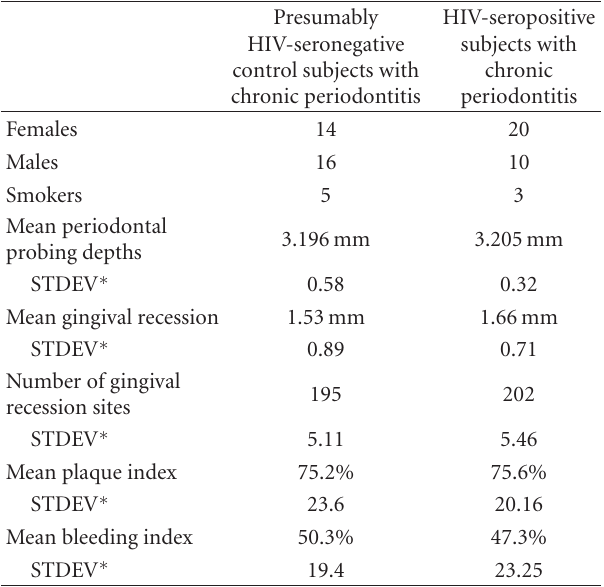
Table 1: Epidemiological features and periodontal indexes of HIV- seropositive subjects with chronic periodontitis and control subjects with chronic